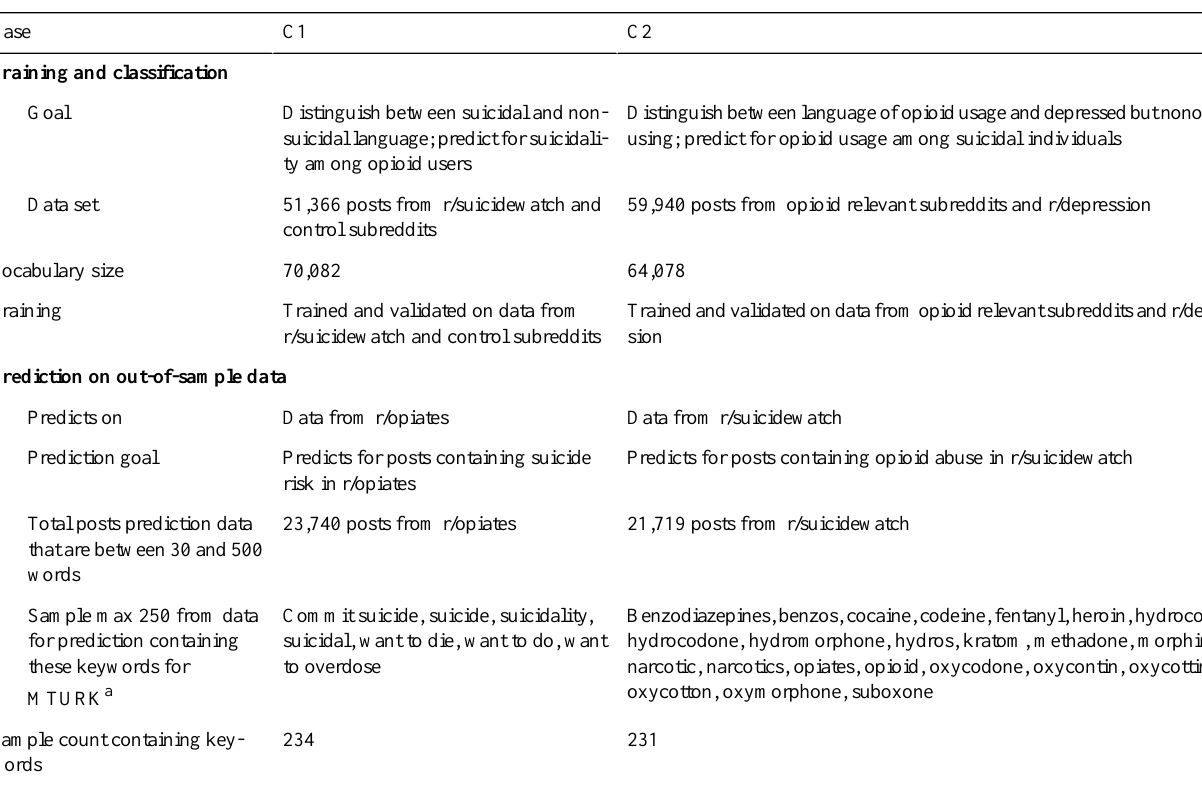
Table 2. Summary of the 2 models for the 2